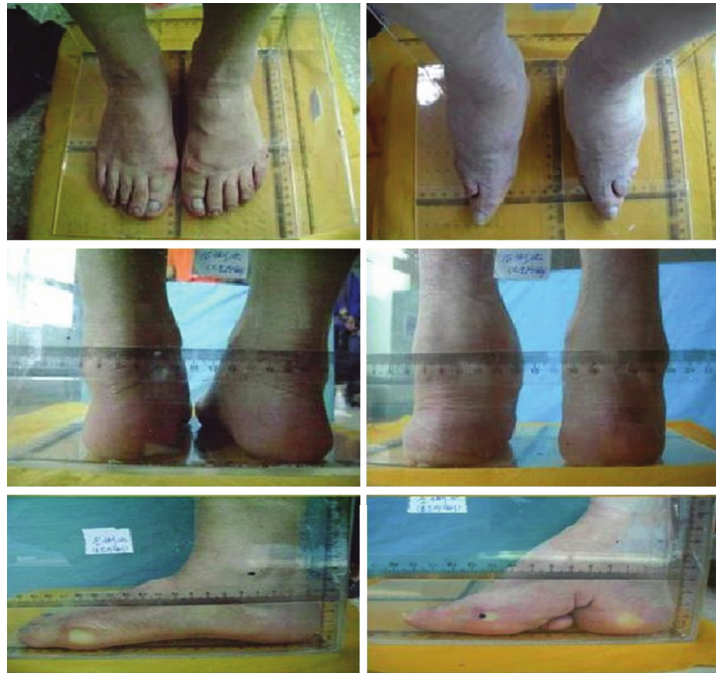
Figure 1: Comparison between the foot-binding deformity and normal foot.